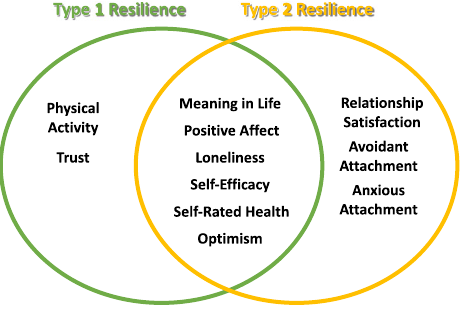
Figure 2. An illustration of the cotwin-control results with significant predictors (p < 0.05), based on Model 3. Hence, the illustration indicates unique and overlapping predictors for both types of resilience, unconfounded by shared environment and